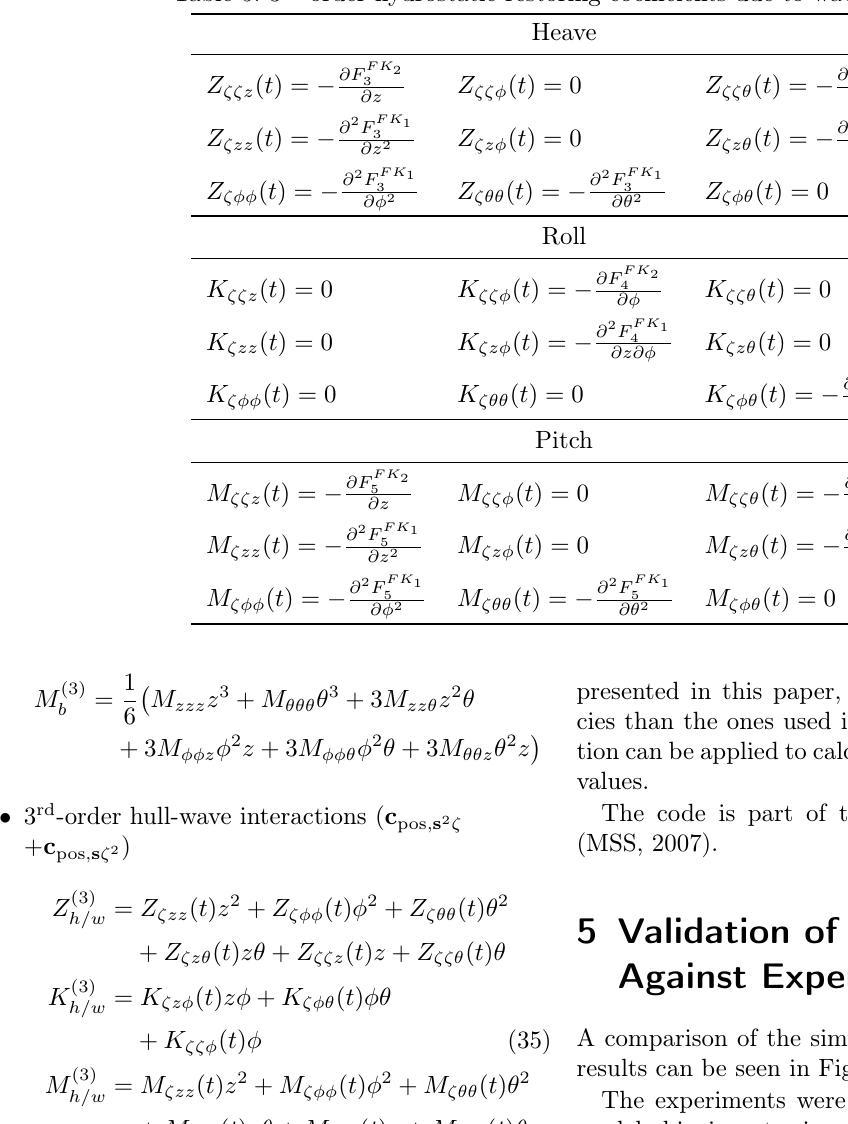
Table 5: 3 rd -order hydrostatic restoring coefficients due to wave